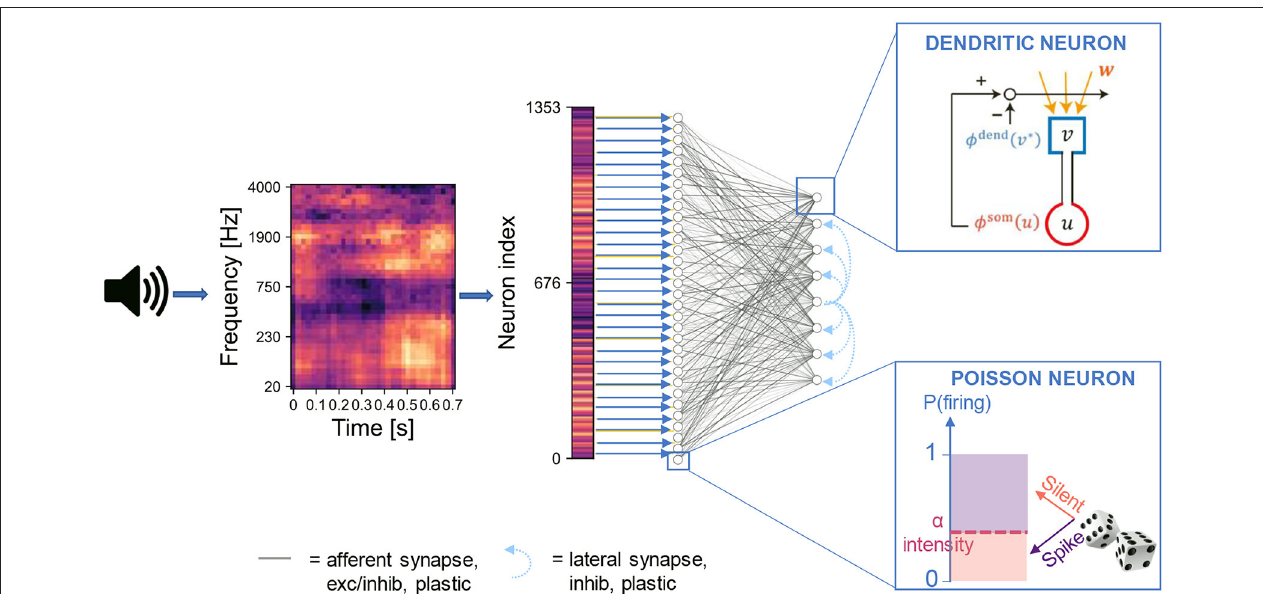
FIGURE 1 | Network architecture. The input signal is pre-processed into a two-dimensional image (i.e., the spectrogram) with values normalized in the range [0,1]. The image is flattened into a one-dimensional array where the intensity of each element is proportional to the Poisson firing probability of the associated input neuron. The neurons in the input layer are connected to those in the output layer through either full connectivity or random connectivity with connection probability p = 0.3. The output neurons are trained following the artificial dendritic neuron learning scheme (Asabuki and Fukai, 2020).